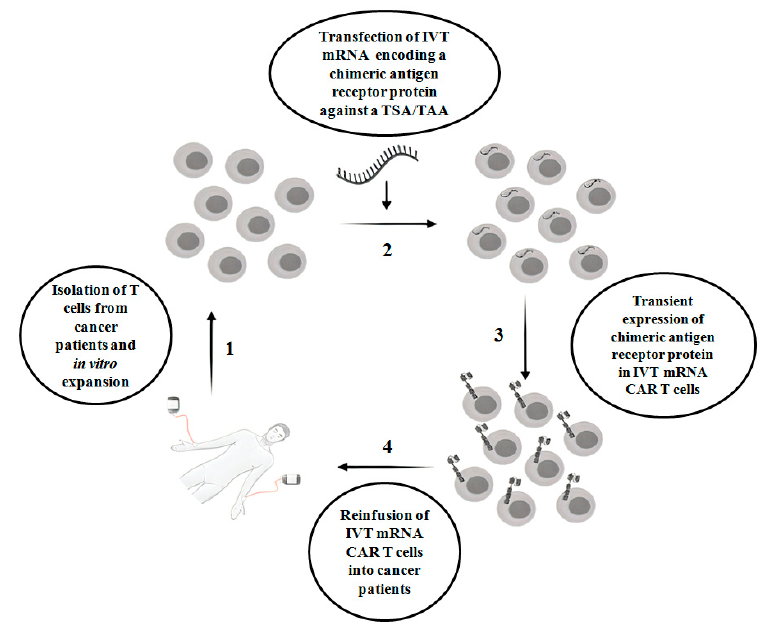
Figure 1. The scheme of IVT mRNA CAR T therapy in cancer patients. IVT mRNA CAR T: In vitro transcribed mRNA chimeric antigen receptor T cells; TSA: Tumor-specific antigen; TAA: Tumor-associated antigen.